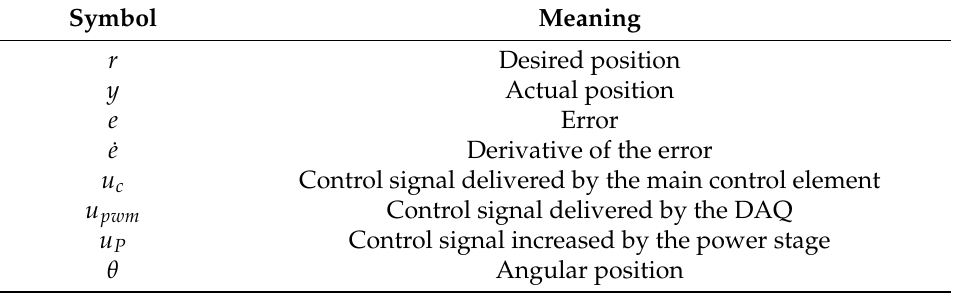
Table A1. Variables used in the control loop of the